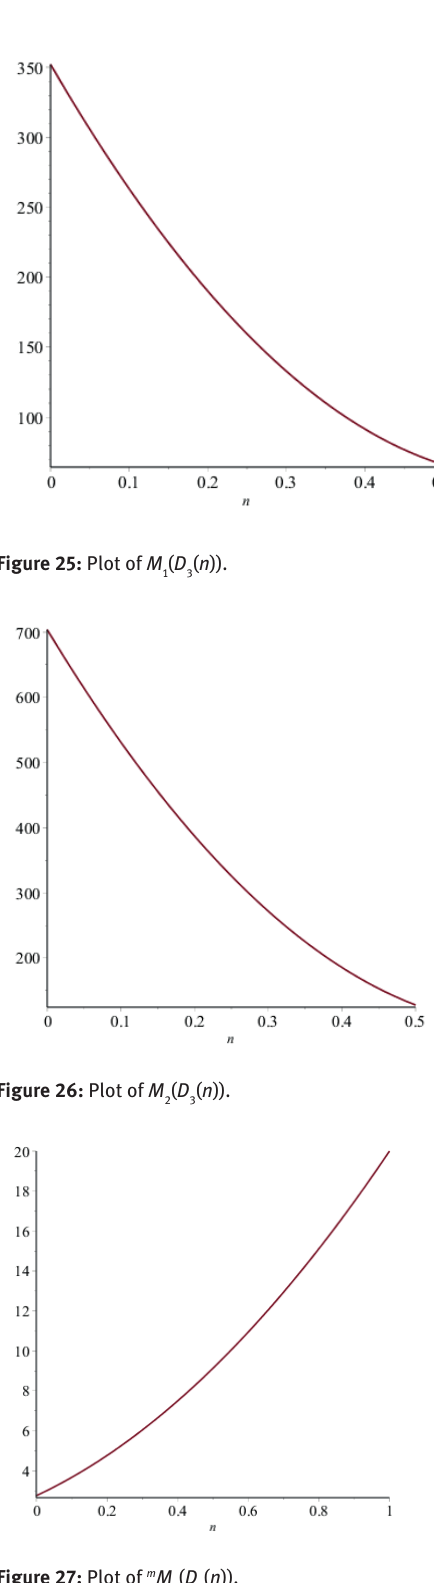
Figure 27: Plot of m M